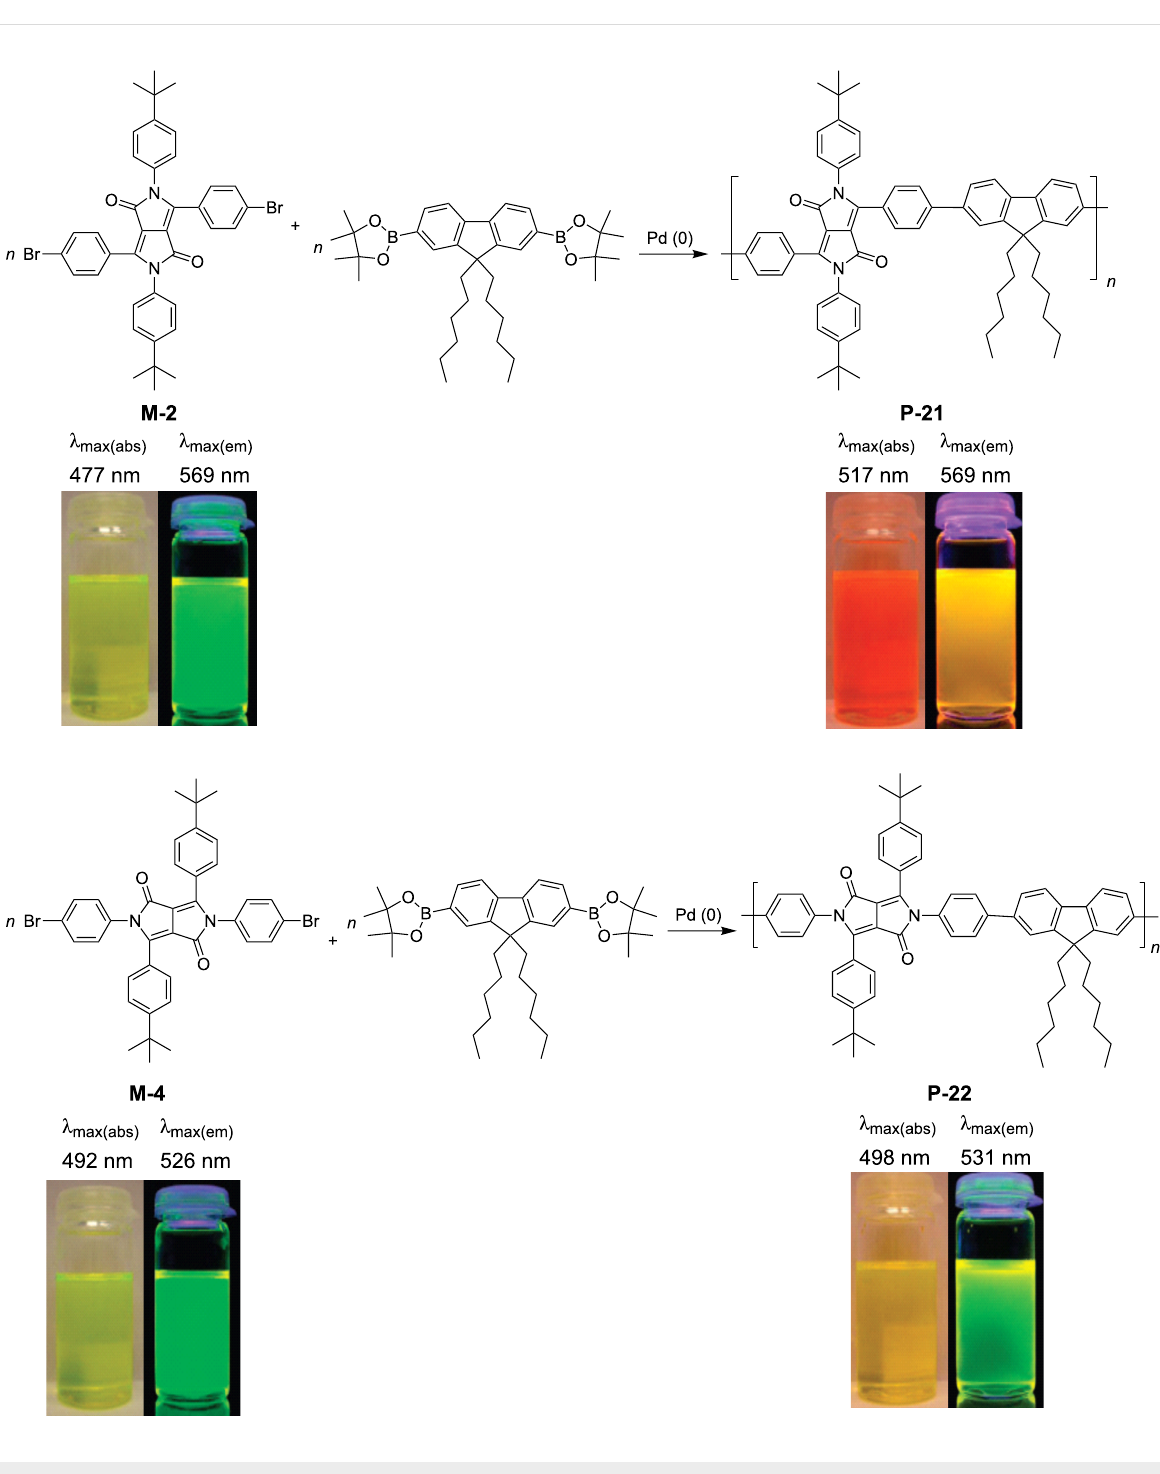
Figure 4: Optical properties of copolymers P-21 and P-22 based on two isomeric diphenylDPP monomer units (from